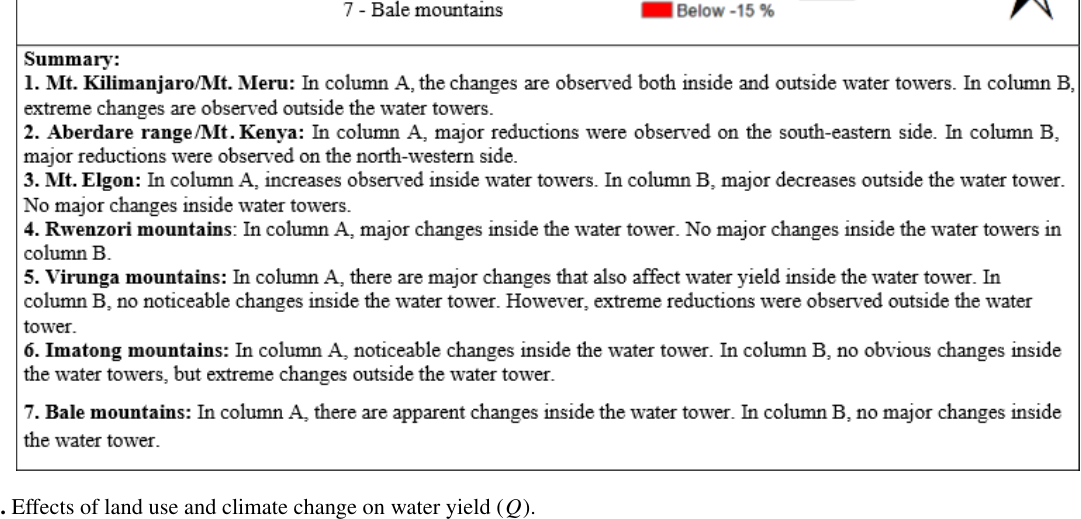
Figure 9. Effects of land use and climate change on water yield ( Q